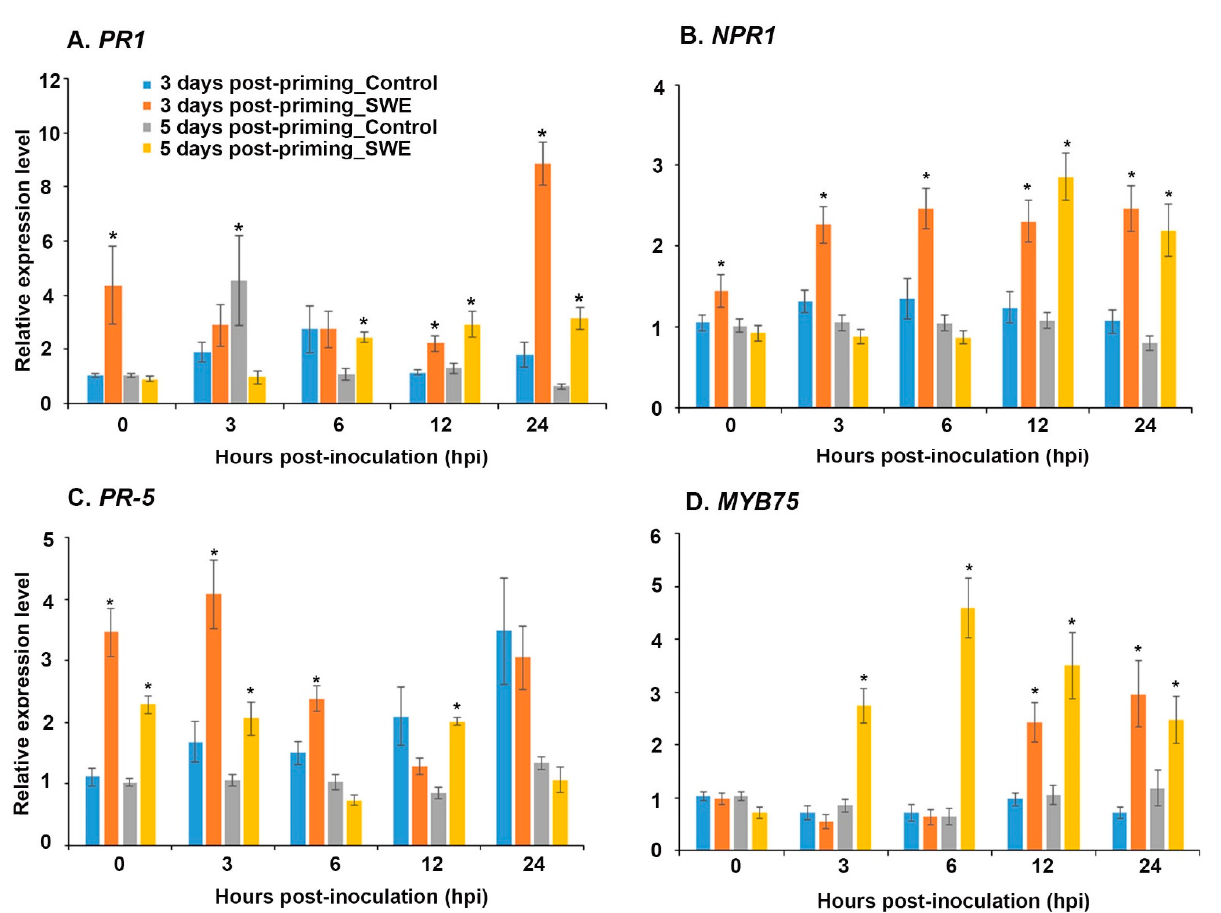
Figure 7. Relative quantification of the expression of defence priming-related genes: ( A ) PR1 , ( B ) NPR1, ( C ) PR5 , and ( D ) MYB75 at 0, 3, 6, 12, and 24 h post-inoculation (hpi) at 3 and 5 days post-priming. Data shown are the mean of three independent biological replicates (each replicate consisted of 10 plants) and bars represent the standard error of the mean. * denotes the significant difference ( p = 0.05) between SWE and control samples at each time point according to Duncan’s multiple range